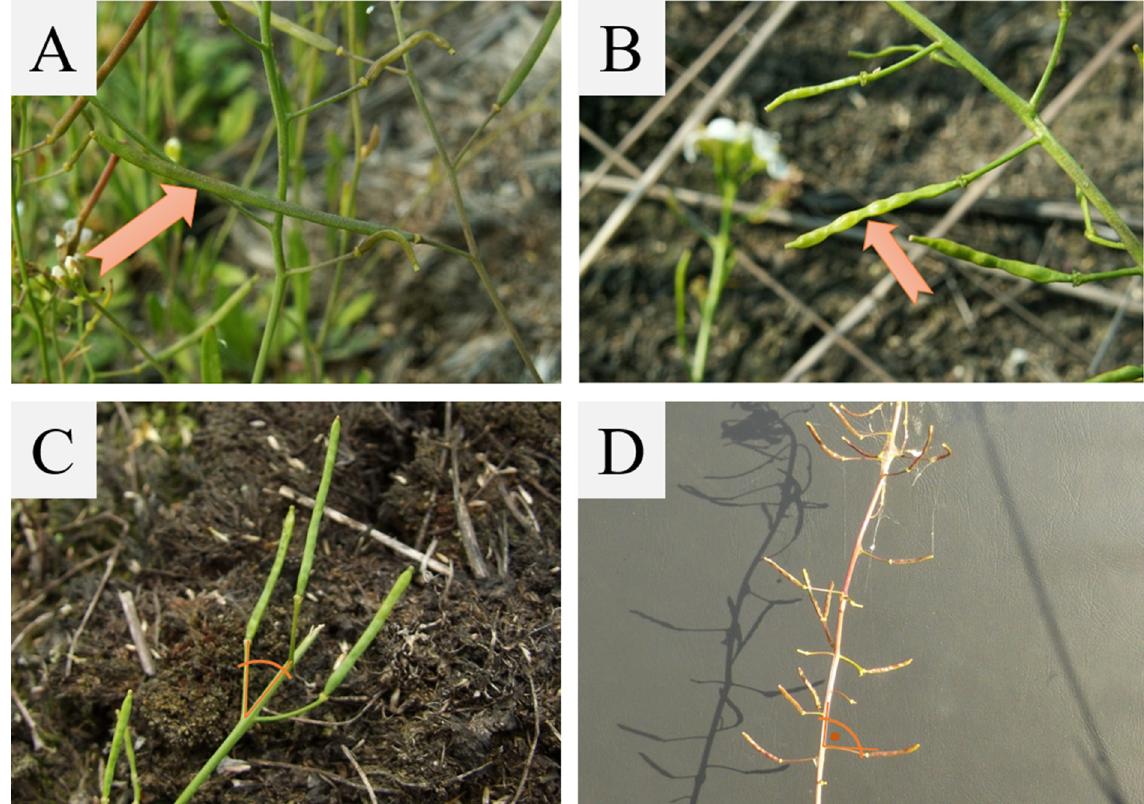
Figure 2. Pictures of the siliques of A. arenosa ( A , C ) compared to the siliques of A. halleri ( B , D ). On picture ( B ), the arrow indicates a characteristic narrowing that is not present in A. arenosa siliques. Pictures ( C ) and ( D ) show the differences in the location of the pedicles relative to the peduncles in both species.